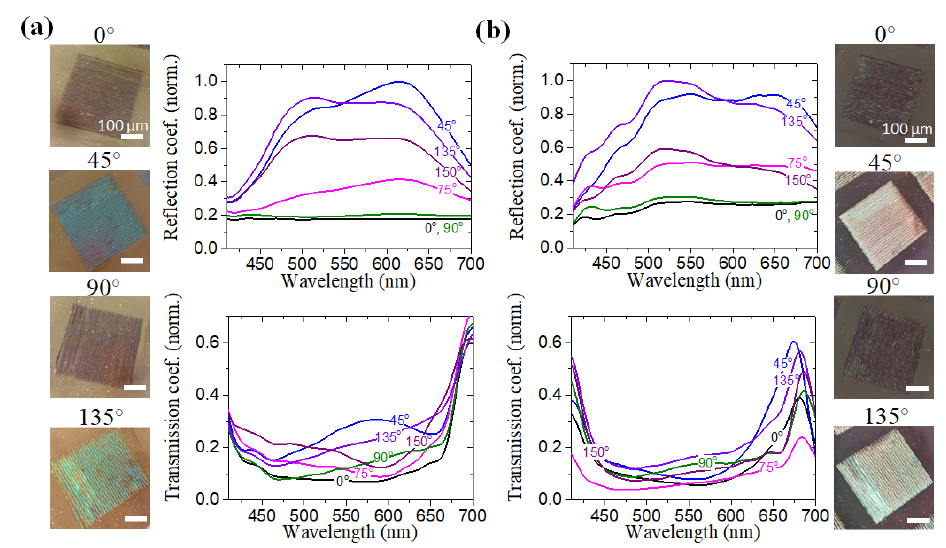
Figure 4. Optical properties of periodic nanocomposite gratings: microgimages of squares and reflection and transmission spectra for different rotation angles of periodic gratings in the crossed- polarizers: ( a ) structure (i) N = 540, F = 21 mJ/cm 2 ; ( b ) structure (ii) N = 540, F = 23 mJ/cm 2